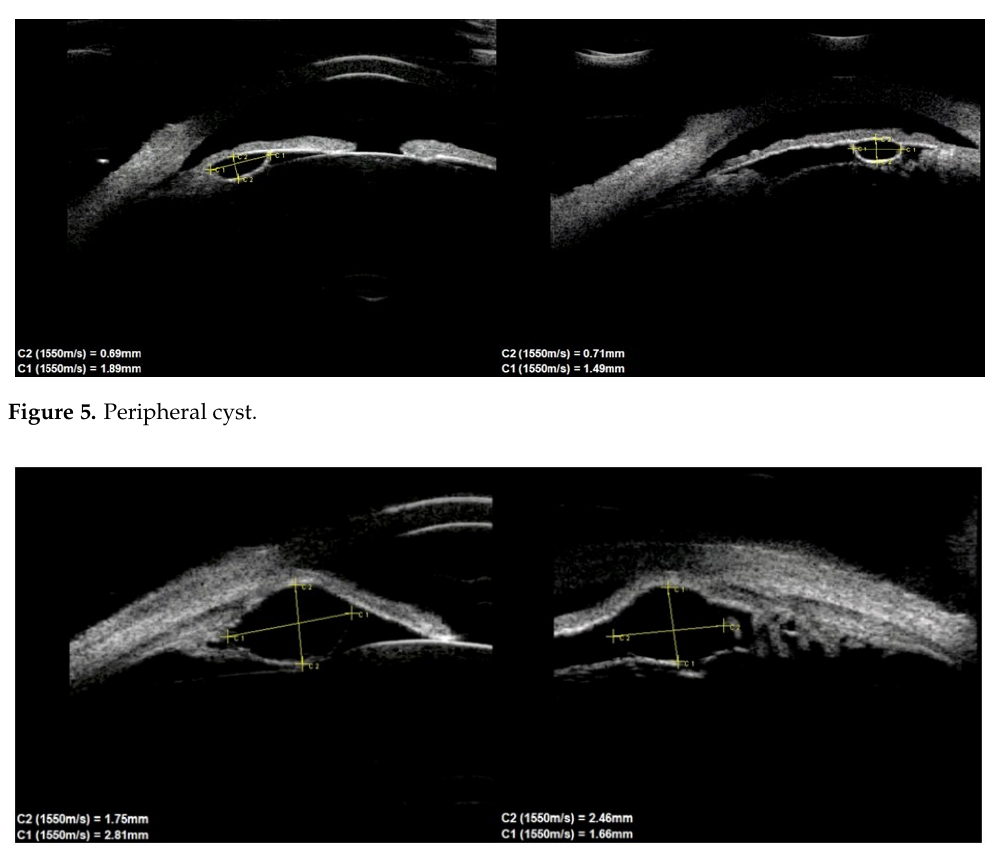
Figure 6. Large peripheral and midzonal cyst.